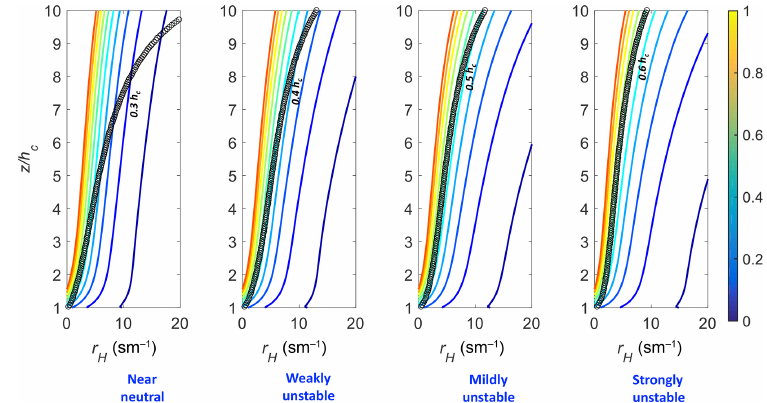
Figure 5. Variations of r H as given by the parameterization of Yang et al. (2001) with height across stability ranges and a wide range of z 0m . Black “ + ” markers indicate the observed r H from LES at any particular stability